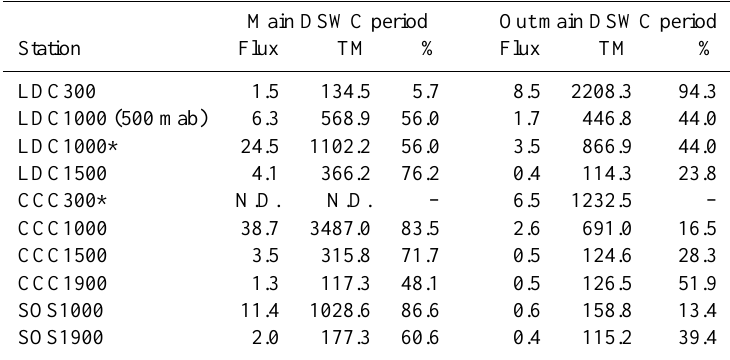
Table 2. Flux (gm − 2 d − 1 ) , total mass (TM) (gm − 2 ) and relative contribution of settled mass to (%) during the main Dense Shelf Water Cascading (DSWC) period (January, February and March) and out of the main DSWC period recovered at each station. ∗ Data gaps, see Fig. 3.